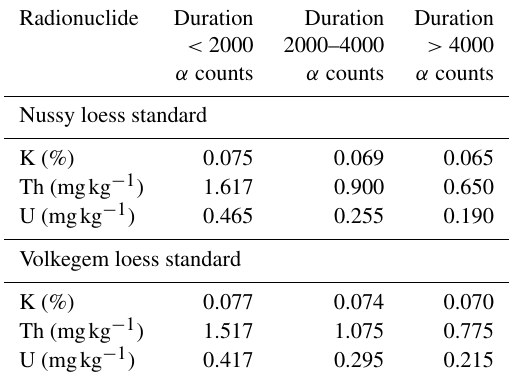
Table 8. Averaged uncertainties for µ Dose measurements of loess standards Nussy (upper part) and Volkegem (lower part) grouped by their respective total numbers of α